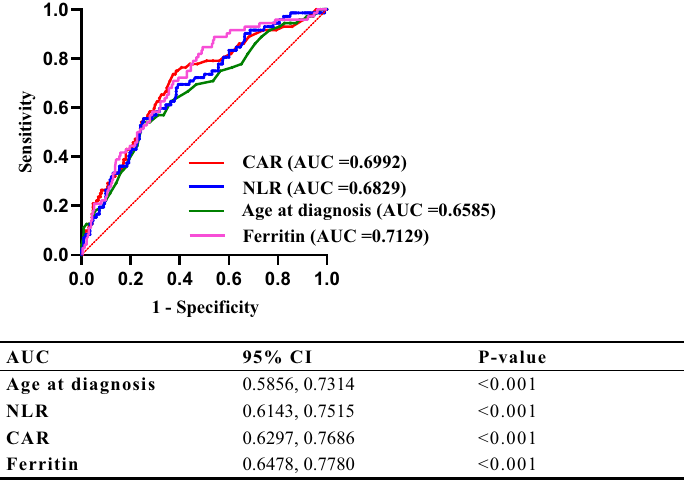
Figure 1. Receiver operator characteristic curves for predicting mortality in idiopathic inflammatory myopathy-associated interstitial lung disease (IIM-ILD). NLR, neutrophil–lymphocyte ratio; CAR, C-reactive protein–albumin ratio; AUC, area under the curve; CI, confidence